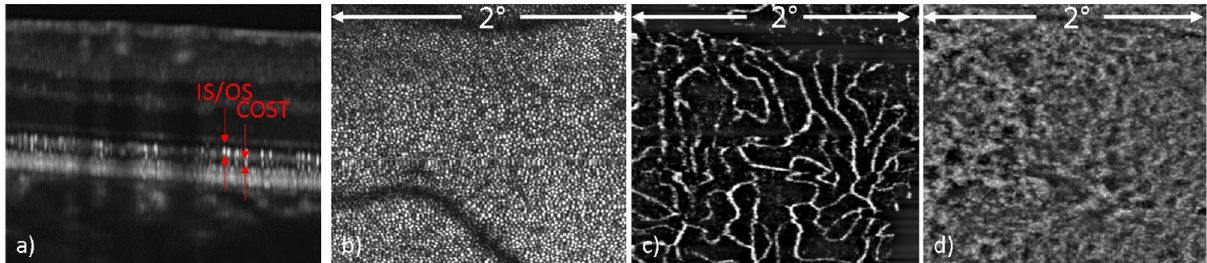
Figure 6. AO-OCT and AO-OCTA images of different layers with the field of view of 2° × 2°. ( a ) AO-OCT B-scan in logarithmic scale, ( b ) AO-OCT photoreceptor mosaic en-face image, ( c ) AO-OCTA deep plexus en-face image, ( d ) AO-OCTA en-face choriocapillaris image. IS/OS inner and outer segment junction, COST cone outer segment